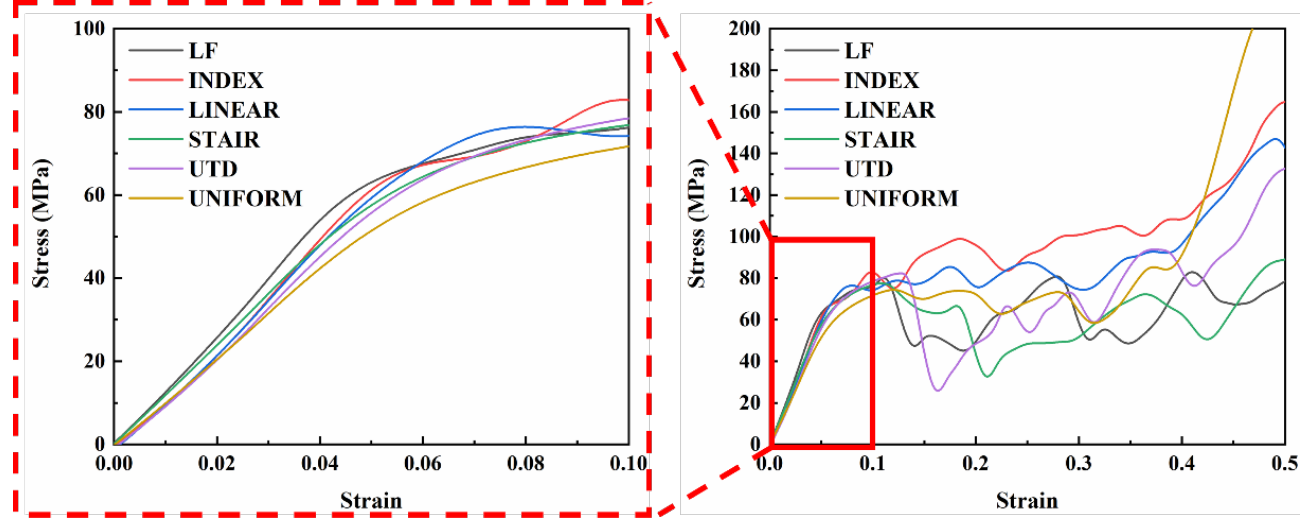
Figure 4. Experimentally determined compressive stress – strain curves for the fabricated lattice structures with different gradients and uniform lattice structures. Table 3. Mechanical properties with different gradients of lattice structure as well as a uniform lattice structure.